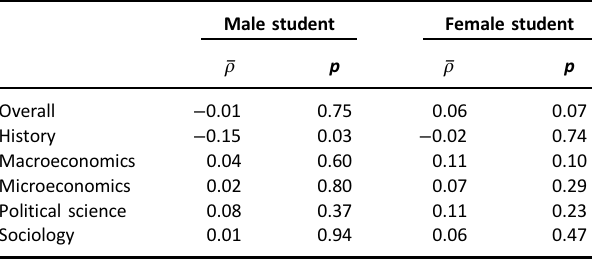
Table 6. Average correlation between student performance and gender concordance.